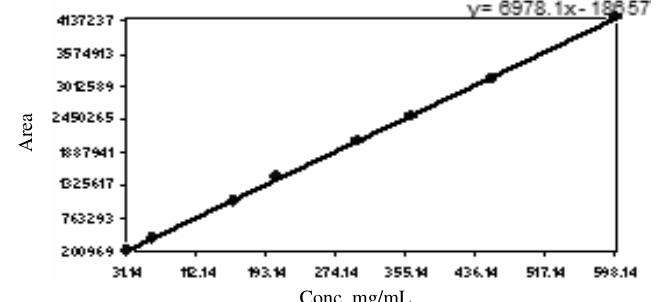
Figure 1. Calibration curve of atazanavir by HPLC